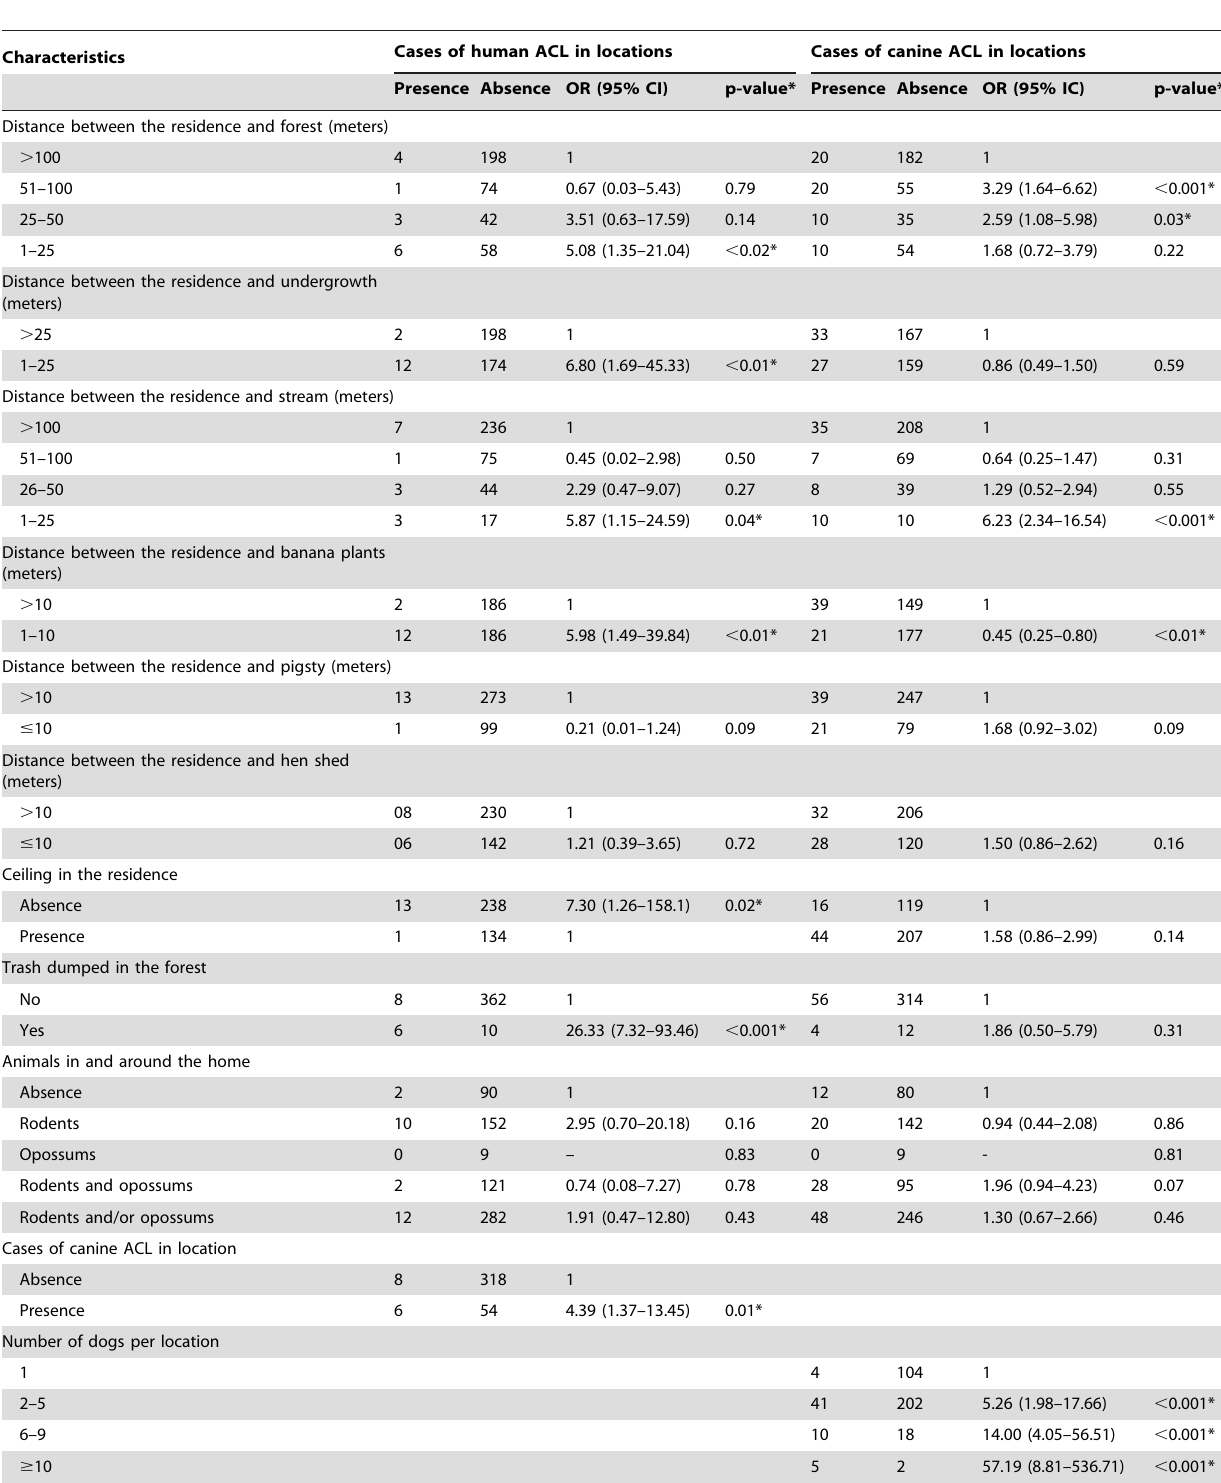
Table 2. Environmental characteristics as risk factors for human and canine cutaneous leishmaniasis in rural locations of the municipality of Arapongas, State of Parana´,